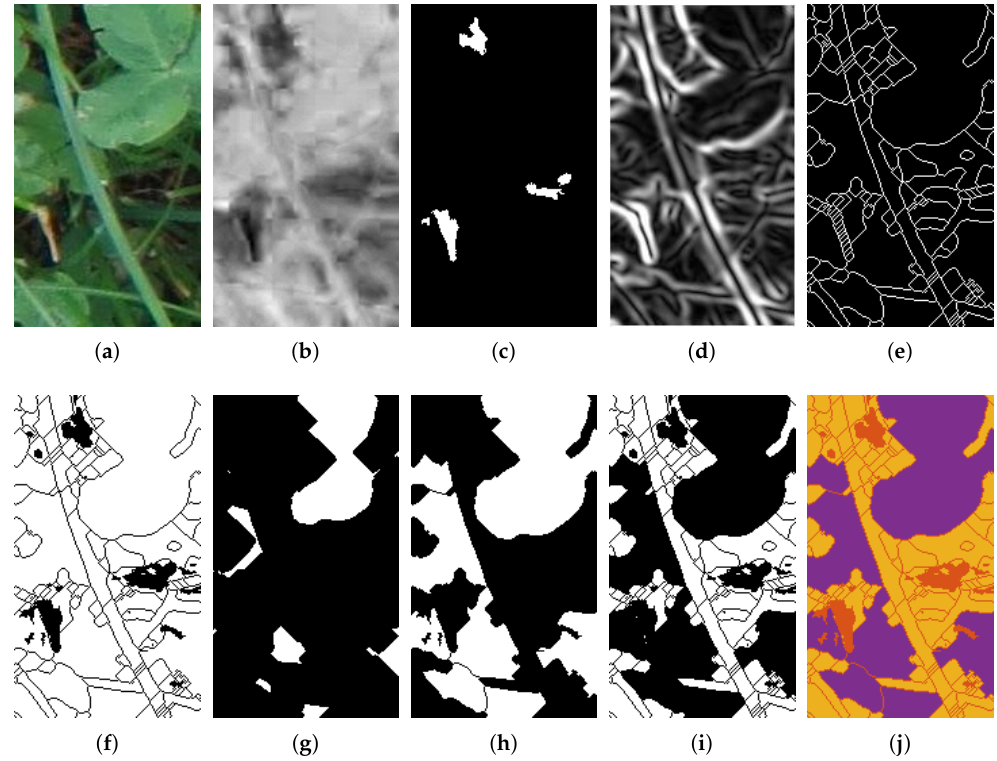
Figure 5. Example of clover and grass segmentation using the proposed improvements. ( a ) Original image captured in indirect sunlight; ( b ) soil ExGR N image; ( c ) threshold soil image; ( d ) gradient of blurred image; ( e ) edge image using watershed; ( f ) segmented image prior to erosion; ( g ) segmented image after the erosions; ( h ) reconstructed clover image using flood-filling; ( i ) grass image; ( j ) classification image. Yellow = grass. Purple = clover. Red = soil/dead